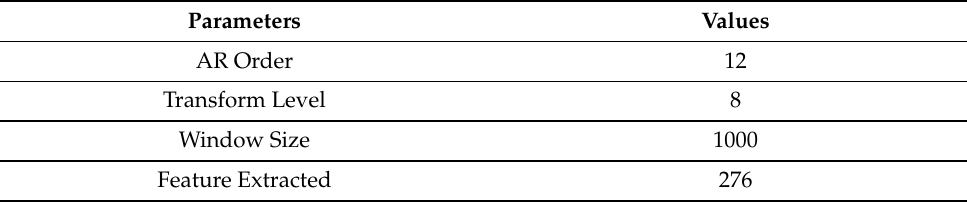
Table 2. ECG Experiment Settings.